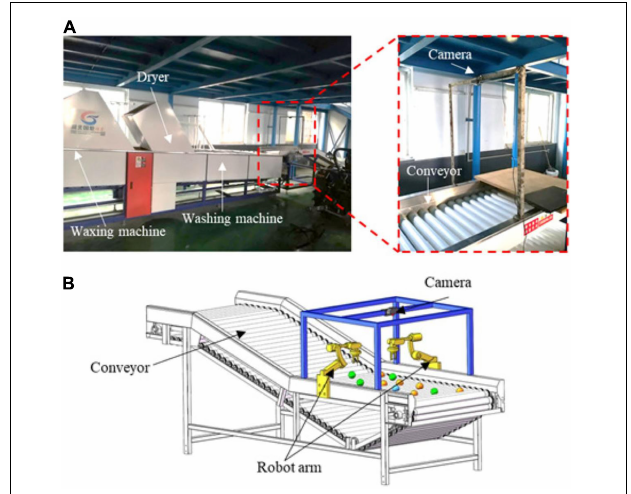
FIGURE 17 | Platform setup and computer vision system (Chen et al., 2021). (A) The citrus processing line was assembled in the laboratory, with a webcam mounted above the conveyor. (B) The diagram shows an automated citrus sorting system using a camera and robot arms, and the robot arms will be implemented in future